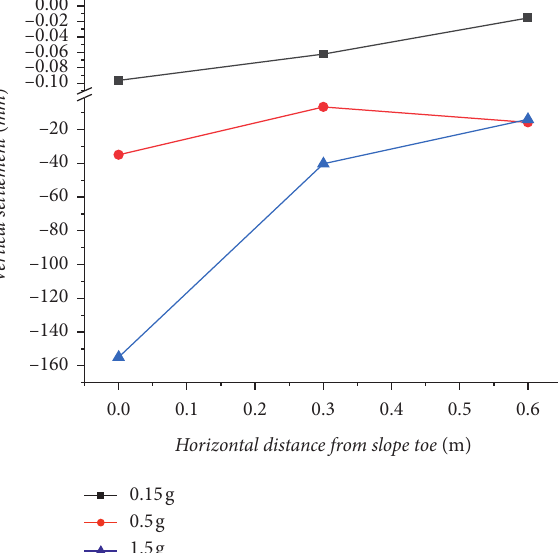
Figure 6: Vertical settlement of the slope along the horizontal direction of the